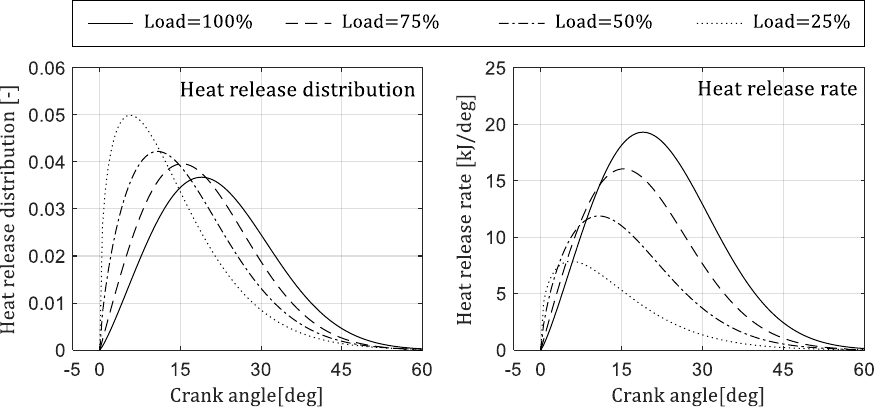
Figure 4. The heat release characteristics of the engine in liquid fuel mode with the WA model.